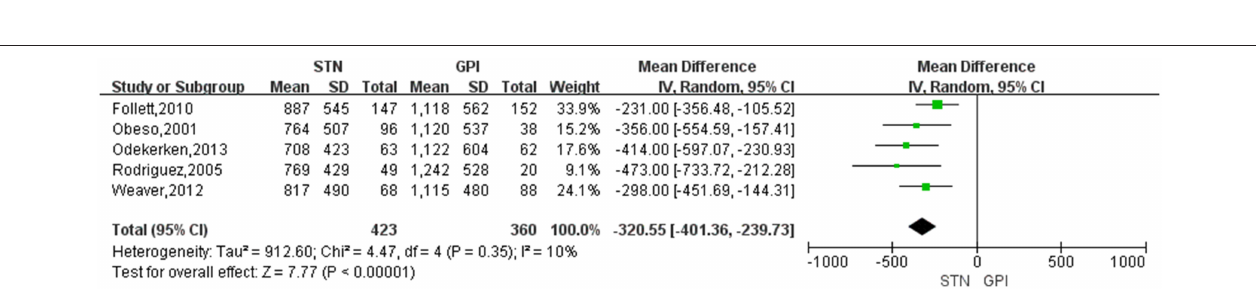
FIGURE 4 | Forest plot: subgroup analyses were conducted according to follow-up periods in dyskinesia score between STN DBS and GPi DBS. GPi, globus pallidus interna; STN, subthalamic nucleus; IV, inverse variance; CI, confidence interval; Std, standardized.